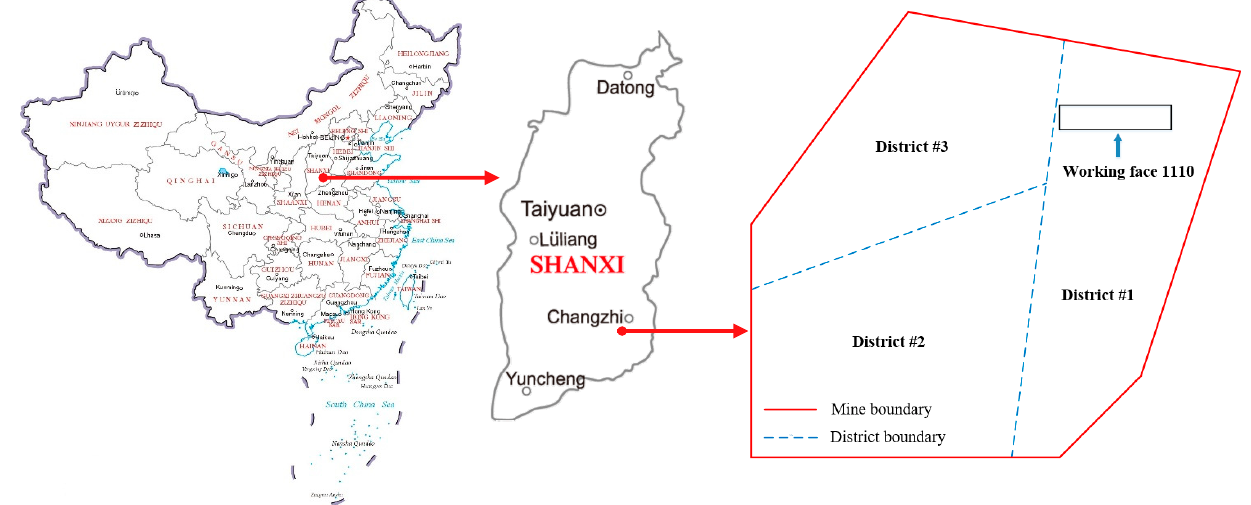
Figure 2. Locations of the Sima Coal Mine and working face 1110.